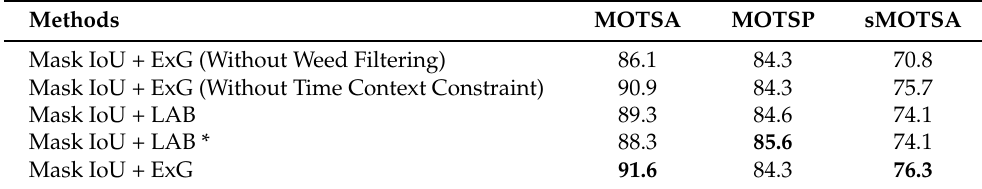
Table 3. The results of leafy greens tracking on testing set. Bold is the best result compared with other methods. * indicates that the model training time is longer, the learning rate is 0.01, and the number of training steps is 8000. sMOTSA can be seen as a combination of MOTSA and MOTSP.